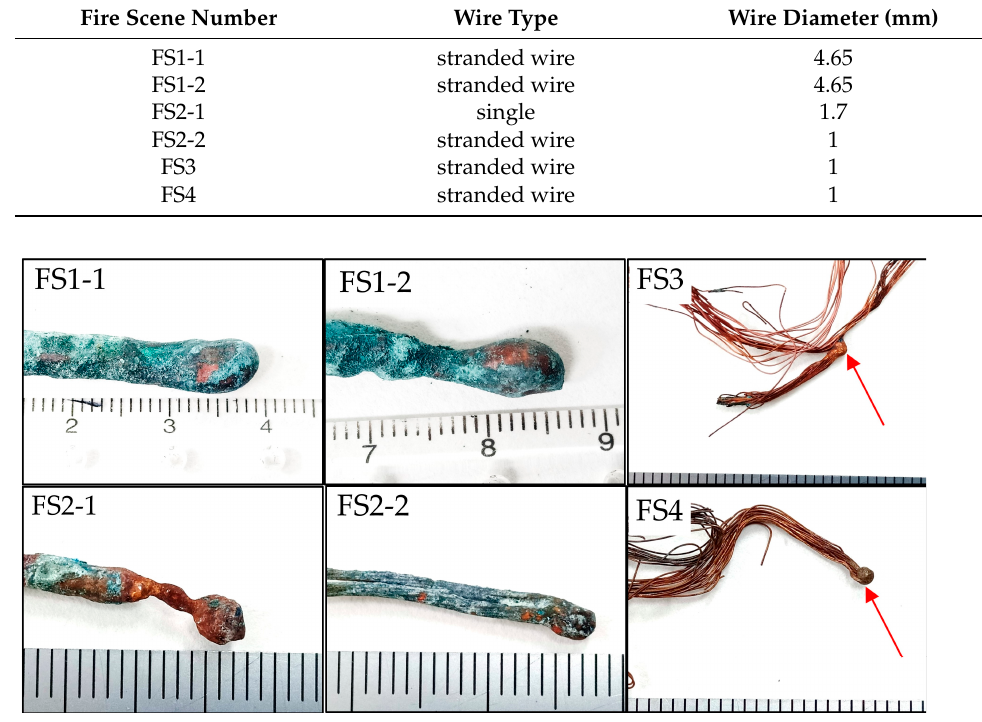
Figure 1. The molten marks on copper wires collected from real-world fire